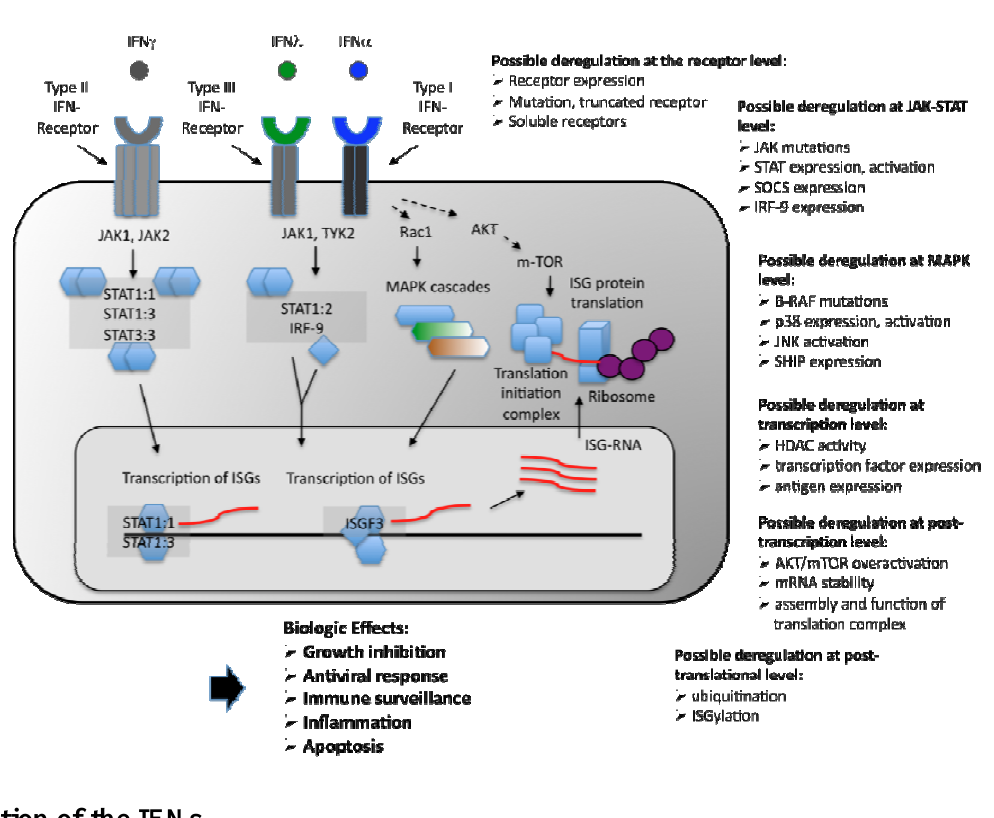
Figure 1. Simplified depiction of Type I, II and III interferon signaling events and outcomes in normal, IFN sensitive cells. Possible deregulation of various IFN signaling components in malignant and IFN resistant cells is also